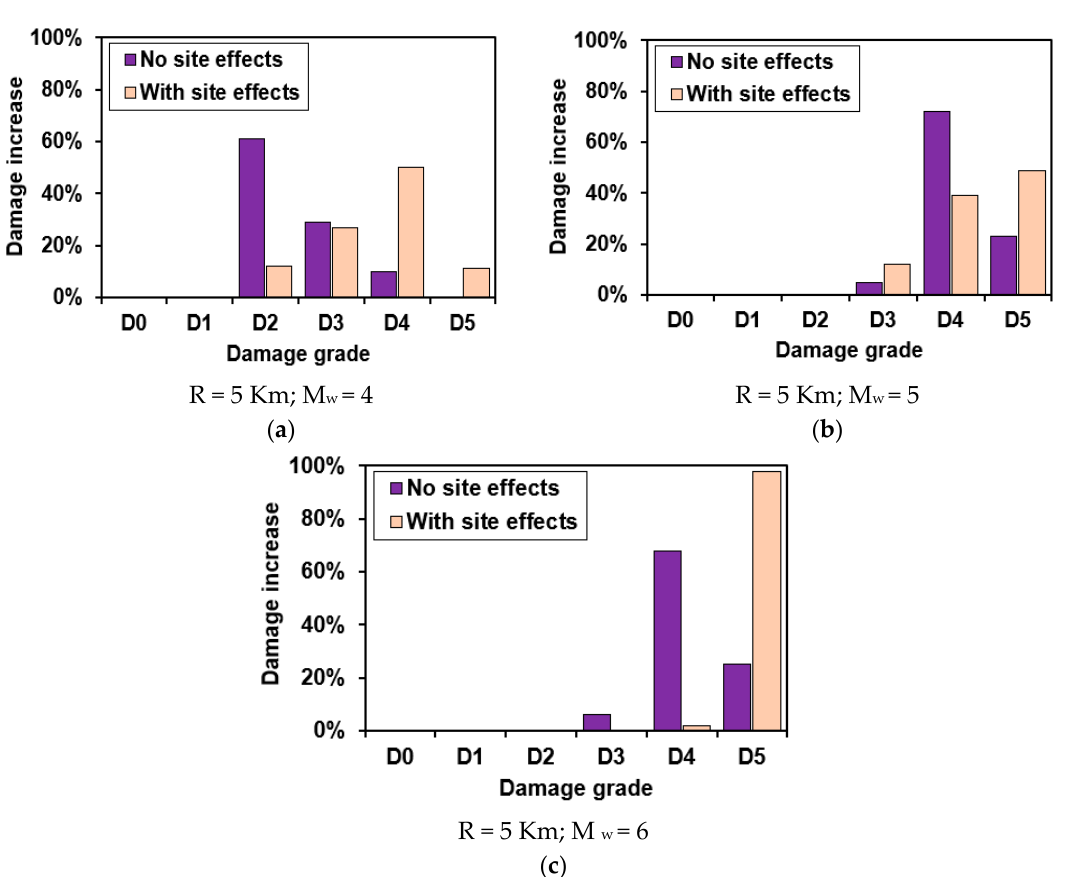
Figure 22. The damage scenarios with and without local seismic effects: comparison of results.